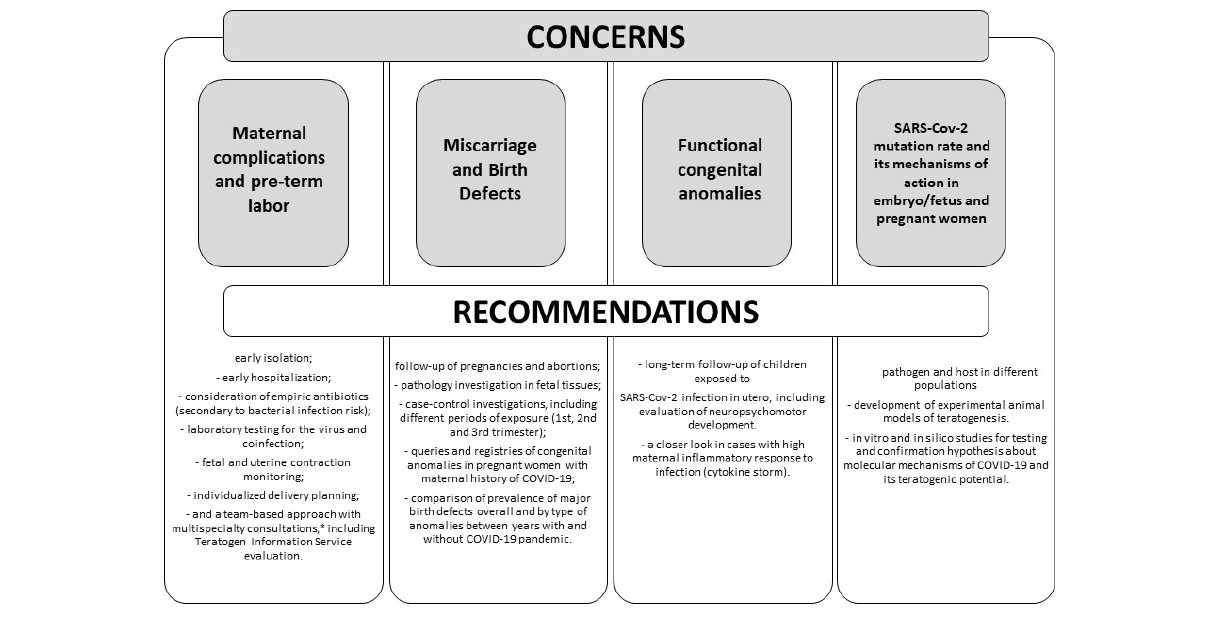
Figure 1 - Summary of concerns (grey squares) and recommendations (white boxes) about COVID-19 infection during